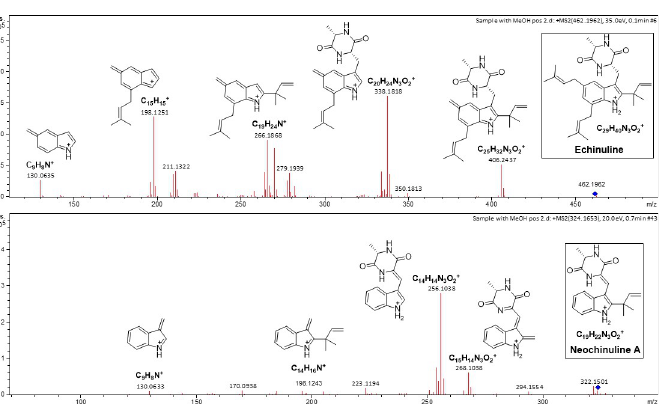
Fig 8. MS 2 spectra of metabolites echinulin and neoechinulin A found in the crude extract from Aspergillus chevalieri (isolate13) by tandem mass spectrometry (HRMS/MS) analysis in ESI positive mode.